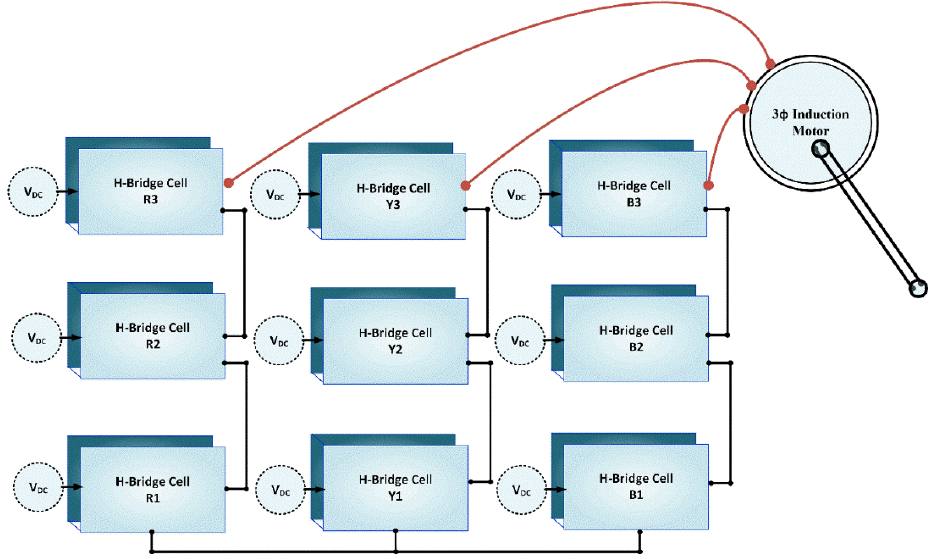
Figure 1. Representation of a three-phase H-bridge cascaded multilevel inverter fed induction